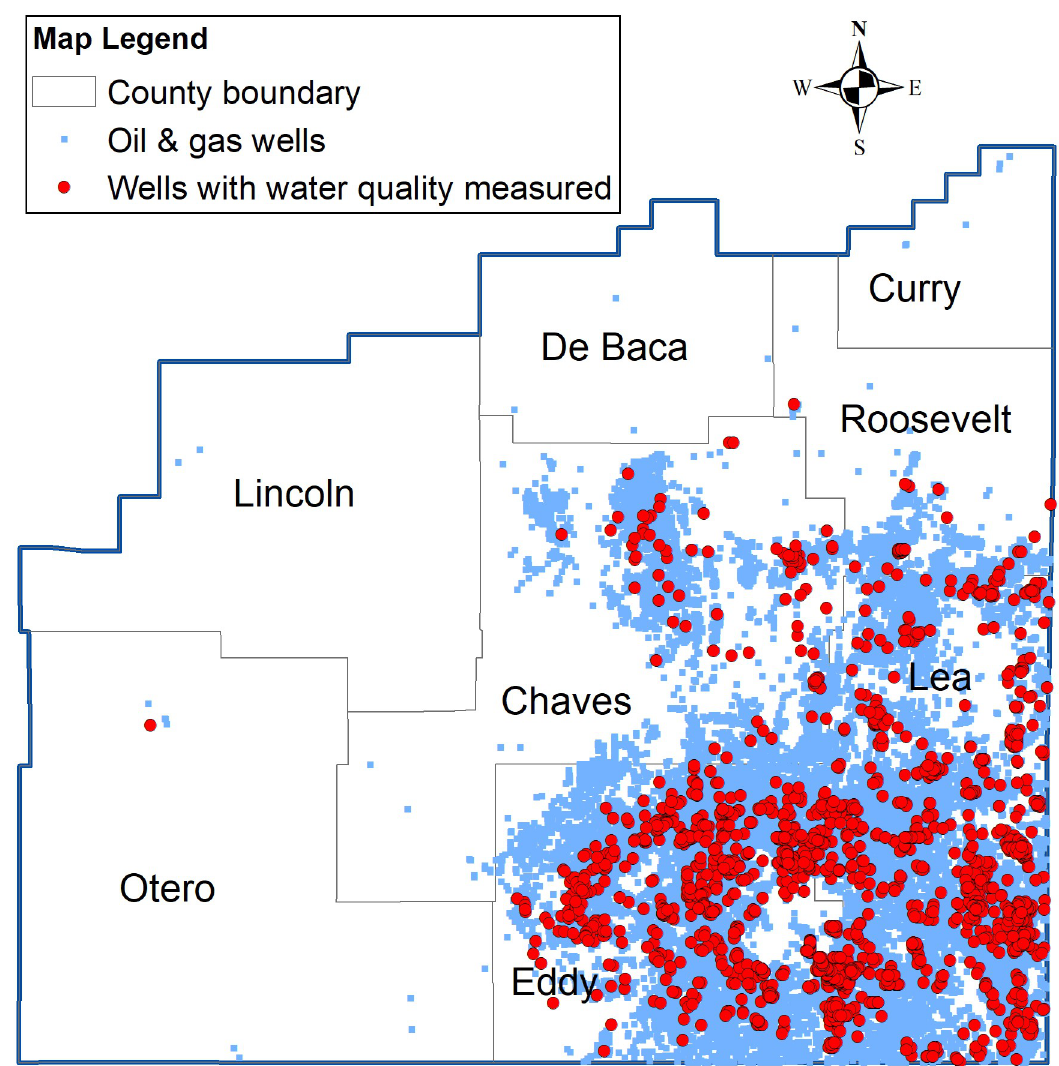
Fig 3. Study area and data sample locations. Note: The author produced the figure in ArcGIS 10.4.1. Data source: The Petroleum Recovery Research Center at New Mexico Tech and the US Census (for GIS